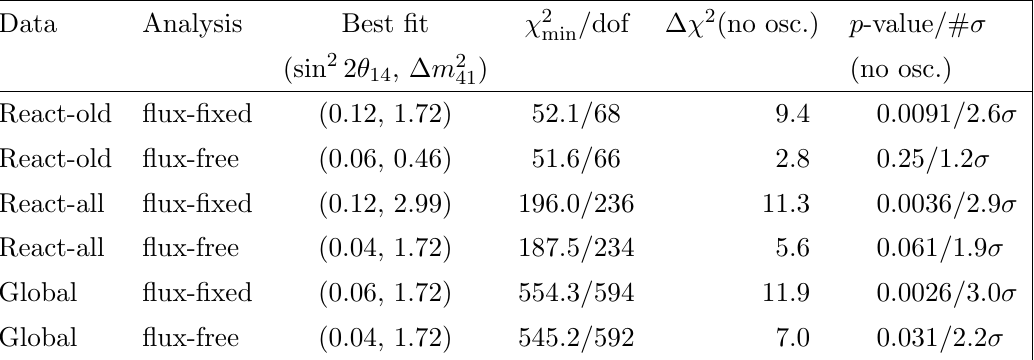
Table 3 . Fit results for various data combinations (1st column) and assumptions about reactor (cid:13)uxes (2nd column). Best (cid:12)t points for (cid:1) m 2 are given in eV 2 . The column \(cid:1) (cid:31) 2 (no osc.)" gives 41 the di(cid:11)erence in (cid:31) 2 between (cid:18) 14 = 0 and the best (cid:12)t point. The last column gives the p -value and the equivalent number of (cid:27) obtained by evaluating the (cid:1) (cid:31) 2 for 2 dof. The data samples are \React- old": reactor data sets predating the 2016 summer conferences, \React-all": combined analysis of { ) all reactor neutrino experiments listed in table 2, \Global": combined ( (cid:23) e disappearance data as discussed in section